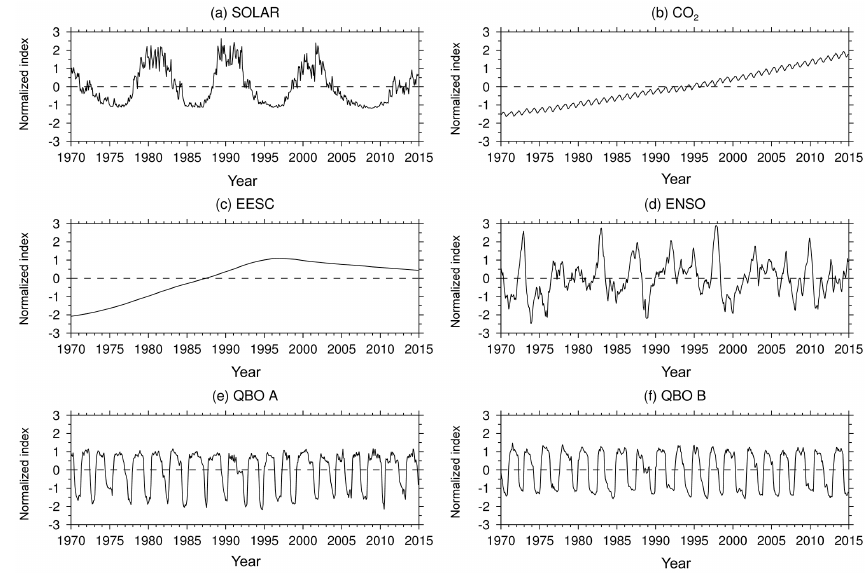
Figure 1. Time series of the six basis functions used in the MLR model. (a) Solar forcing based on F10.7cm solar radio flux; (b) a trend term based on the monthly CO 2 concentration at Mauna Loa; (c) equivalent effective stratospheric chlorine; (d) the Nino 3.4 index for ENSO; (e, f) two QBO indices based on tropical zonal winds at 50 and 30hPa. The time series are in units of standard deviation and the time period is 1970–2015. A volcanic term is not included because the 2-year periods following the two major tropical volcanic eruptions in this epoch (El Chichón and Mt Pinatubo) are excluded from the regression analysis.